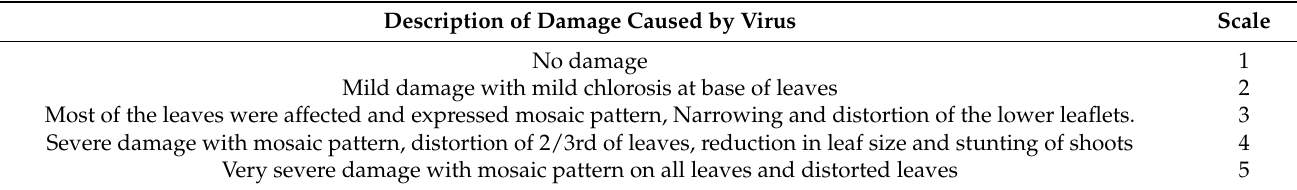
Table 2. Scale followed to assess the CMD disease severity as explained by Hahn et al. [25]. Description of Damage Caused by Virus Scale No damage 1 Mild damage with mild chlorosis at base of leaves 2 Most of the leaves were affected and expressed mosaic pattern, Narrowing and distortion of the lower leaflets. 3 Severe damage with mosaic pattern, distortion of 2/3rd of leaves, reduction in leaf size and stunting of shoots 4 Very severe damage with mosaic pattern on all leaves and distorted leaves